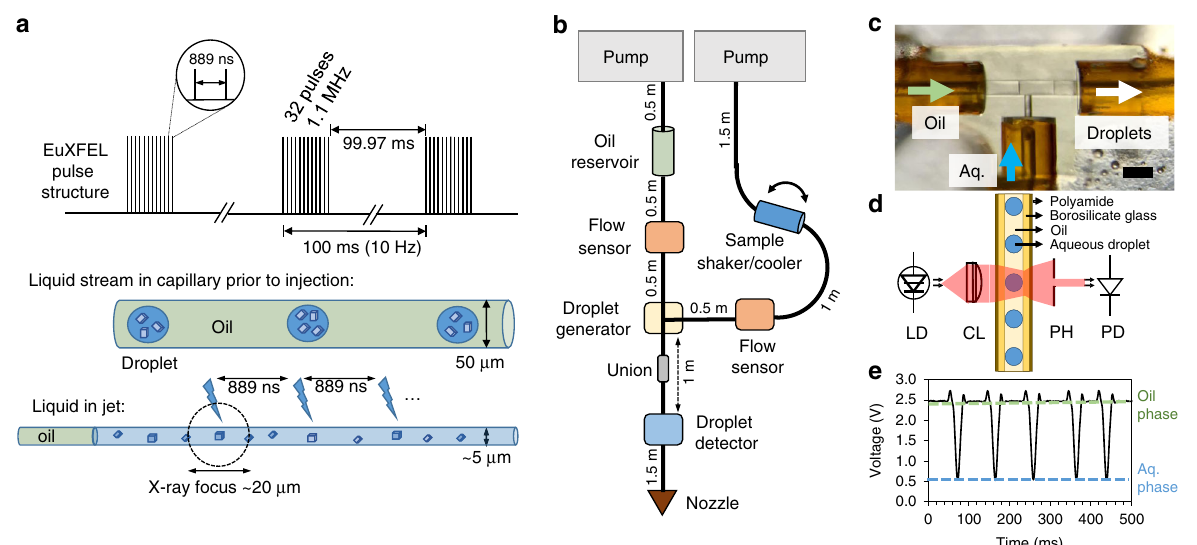
Fig. 1 Experimental schematics. a Top: EuXFEL pulse structure for the early user experiment phase in which this experiment was carried out. Middle: Schematic of the segmented fl ow with droplets of mother liquor carrying crystals formed in an oil phase. Bottom: Schematic representation of the liquid stream leaving the GDVN, where the liquids are stretched out to form a thin jet. The stretched out droplets are larger than a pulse train of ~30 µ s. b Schematics of the fl uidic components needed to achieve segmented droplet injection at the SPB/SFX chamber (distances for each fl uidic line are indicated and are approximate). c Bright fi eld optical microscopy image of an assembled droplet generator. d Schematic of the droplet detector and representative components: laser diode (LD), collimating lens (CL), pinhole (PH), and photodetector (PD). e Representative voltage plot of the optical detector for aqueous-in-oil droplets. Scale bar is 100 µ m in c . Source data are provided as a source data fi